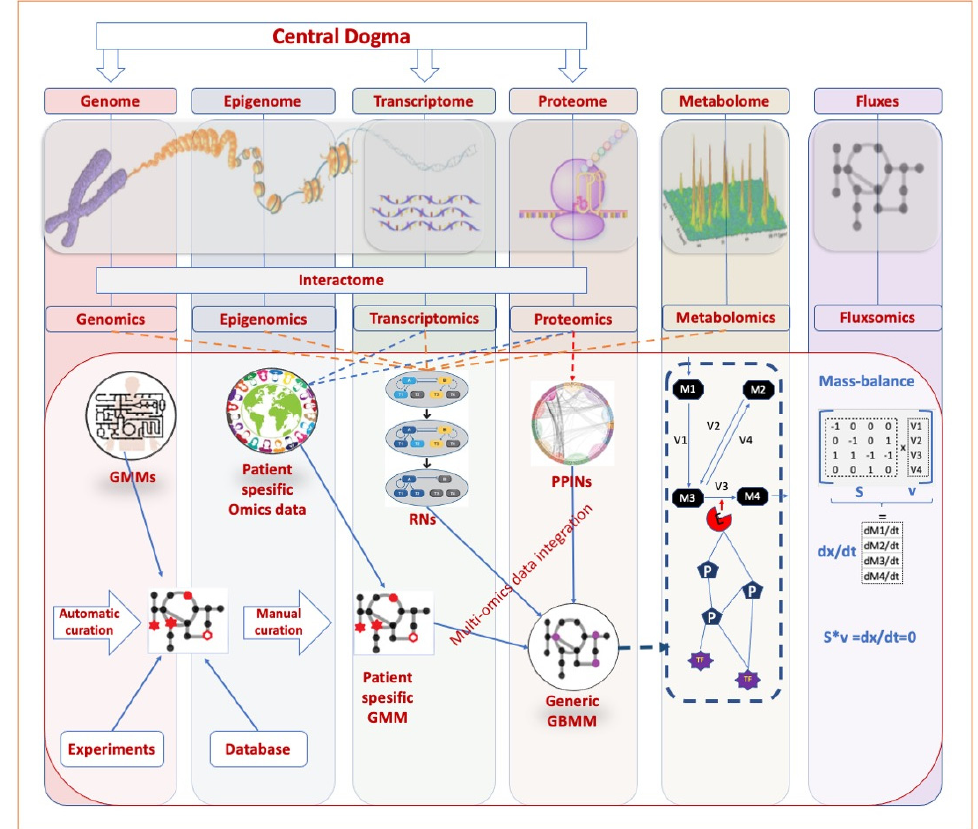
Figure 2. Multi − omics integration perspective. The central dogma describes the flow of genetic information within a biological system. In multi-omics approaches, different ohmic layers can be used separately or together for various purposes. The glioblastoma-specific metabolic model (GBMM) is developed using generic metabolic models (GMMs), experimental results, databases, and patient-specific omics data. Regulatory networks (RNs) are clusters of macromolecules belonging to different omics layers that interact to control the expression level of various genes. Protein-protein interaction networks (PPINs), formed by the interaction of two or more proteins, contain the information of the subnetworks associated with the disease. Using RNs, PPINs, and GBMM together, the effect of different omics layers on the metabolic profile can be estimated. M represents the metabolite (M1, M2, M3, M4); E represents the enzyme; P represents protein. TF: Transcription factor; S: Stochiometric matrix; V: Flux rate (V1 V2, V3, V4). The navy dashed-lined quadrangular represents a cell boundary.